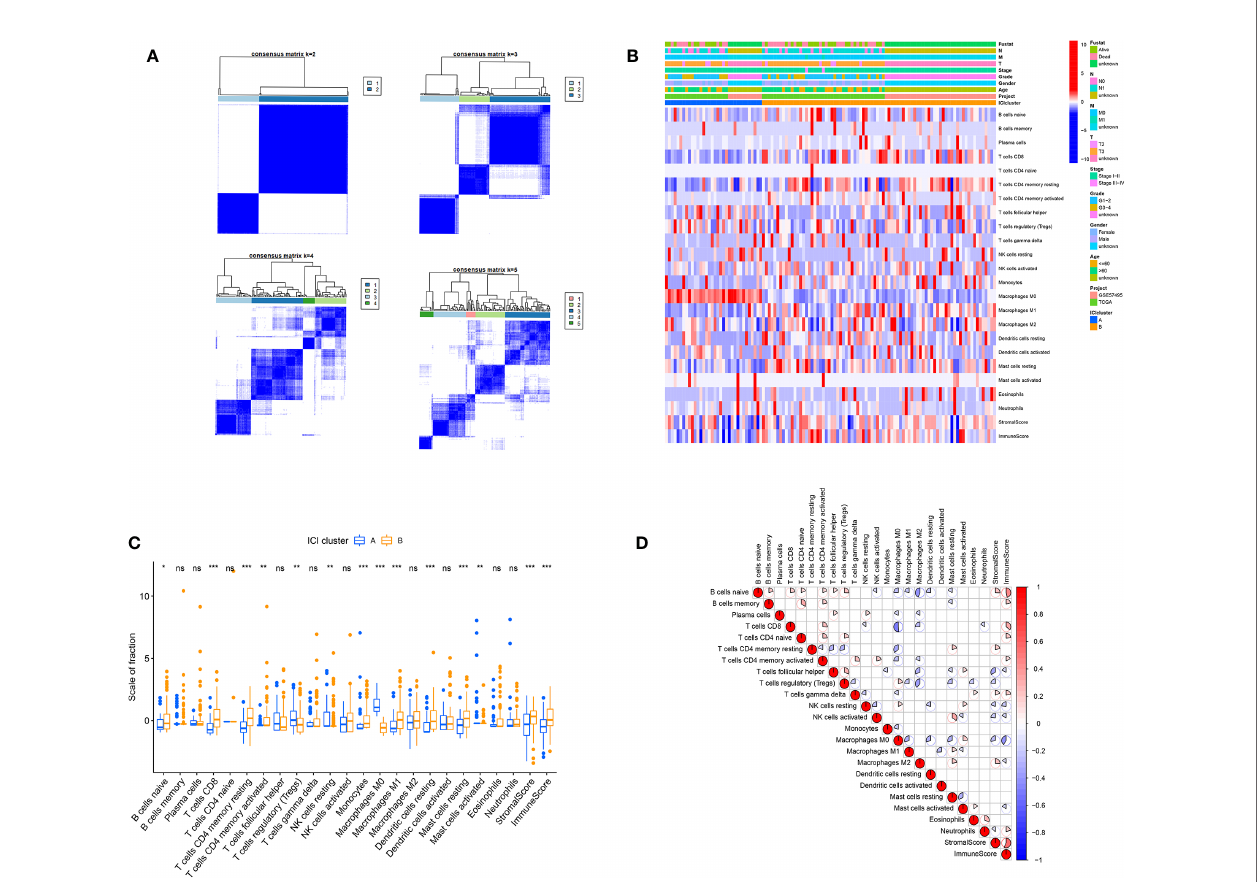
FIGURE 2 | The ICI pro fi le in PC TME. (A) Consensus matrixes of PC samples, representing each k (k=2 – 5). (B) Unsupervised clustering of TIICs in PC cohorts. Rows denote TIICs and columns denote PC sample. (C) TIICs fractions in both ICI clusters. Signi fi cance computed using the Wilcoxon test, * P < 0.05; ** P < 0.01; *** P < 0.001. ns, not signi fi cant. (D) Cellular interaction of the TIICs